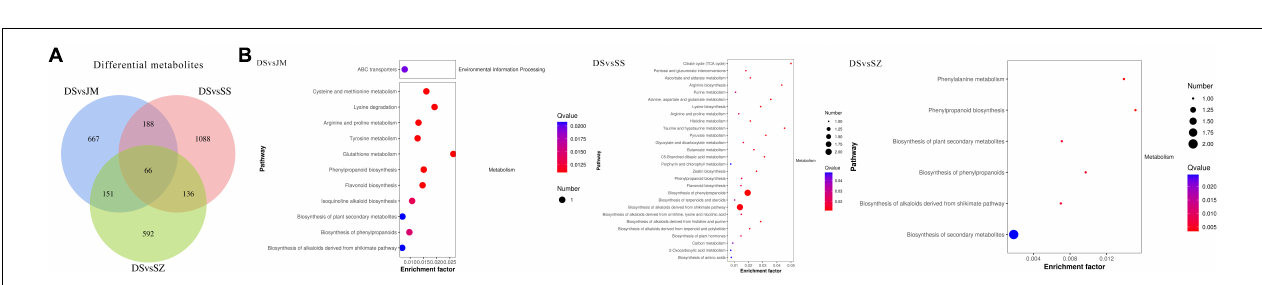
FIGURE 5 | Statistics of differential metabolites. (A) Veen plot of differential metabolites and (B) KEGG enrichment pathway of differential